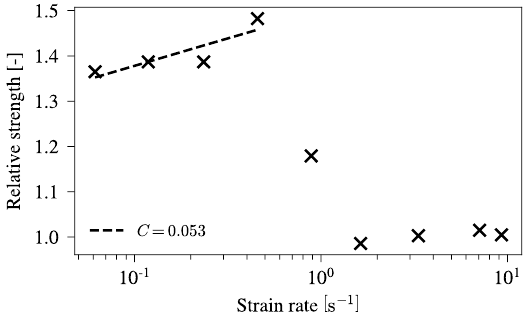
Fig. 13 Simulated relative strengths as a function of strain-rate proving the correct behaviour of the immediate element failure model for the first four tested strain-rates.